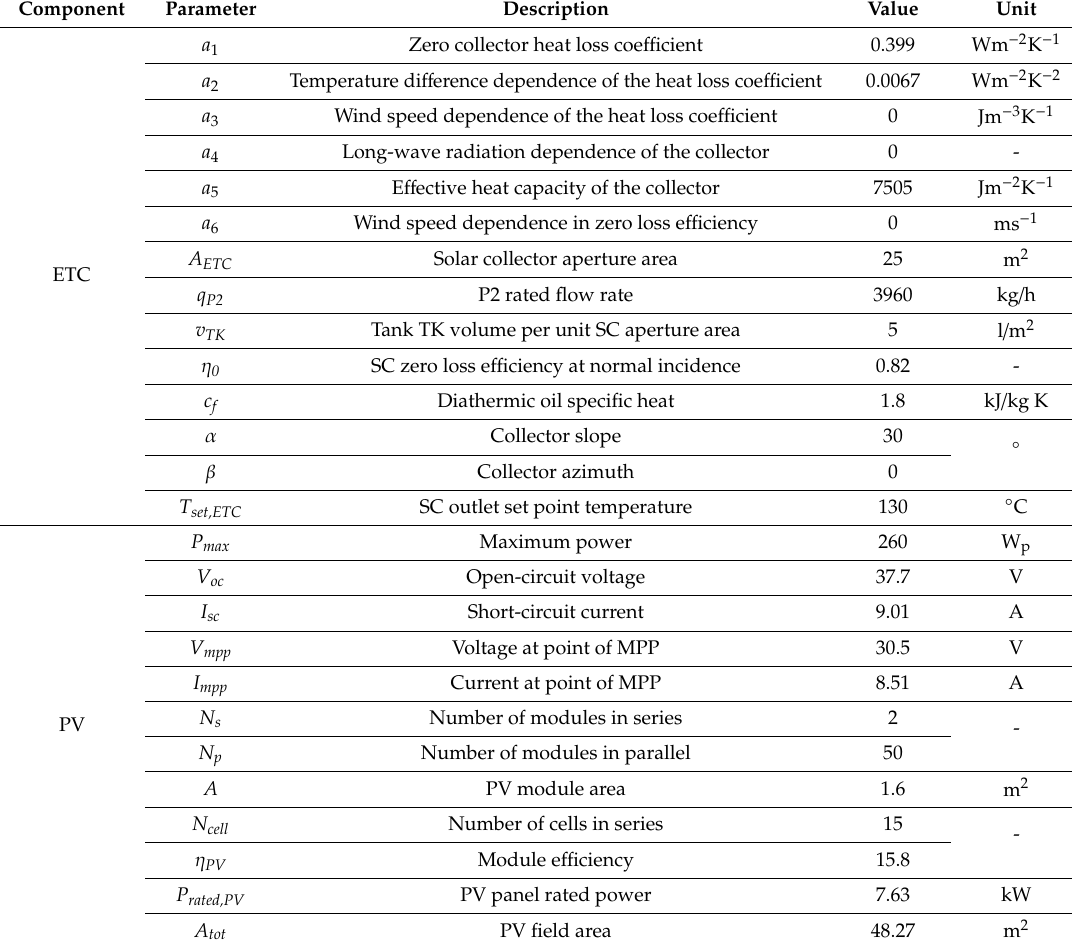
Table 3. Design and operating parameters (2).